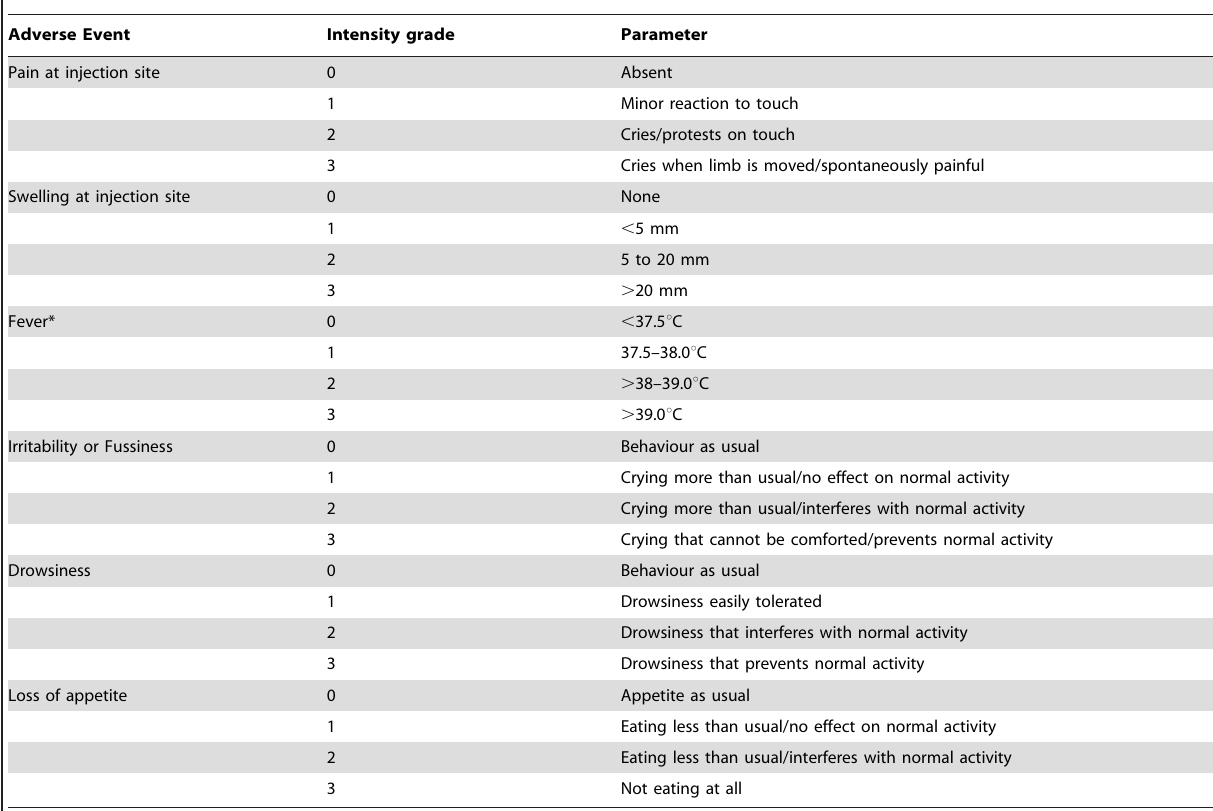
Table 1. Intensity scales for adverse events following vaccination.